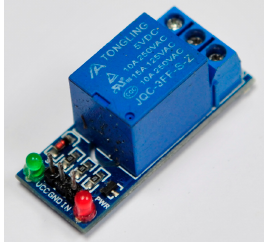
Figure 8. Liquid–crystal display (LCD) module.